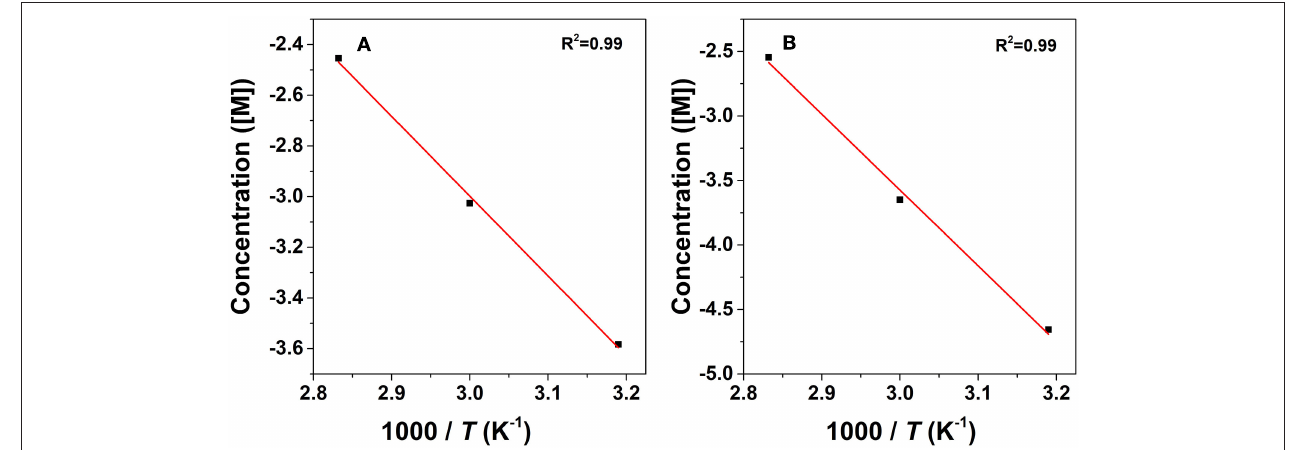
FIGURE 10 | Arrhenius plots for the conversion of ML to GVL: hydrogenation step (A) and transesterification step (B) .